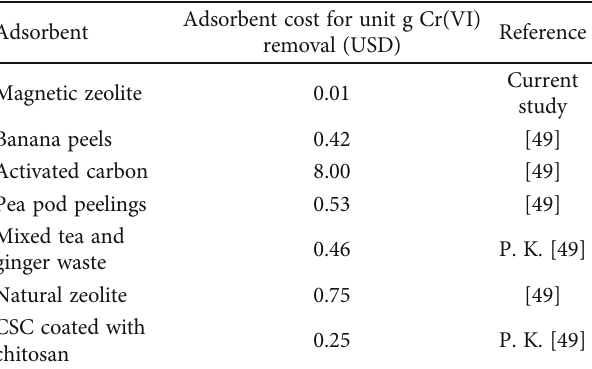
Table 11: Removal e ffi ciency and cost for removal.